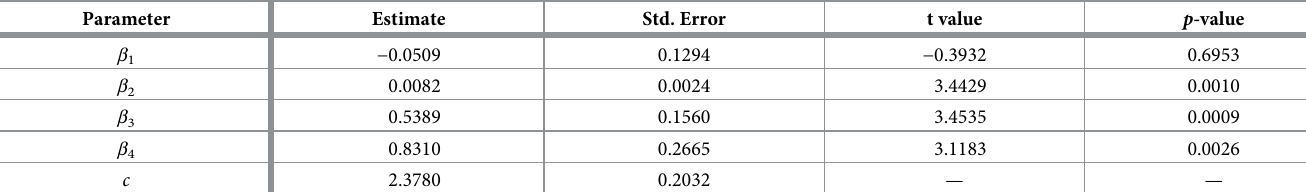
Table 6. Fitted UBXII regression for the dropout proportion in the Brazilian zootechnics course. Parameter